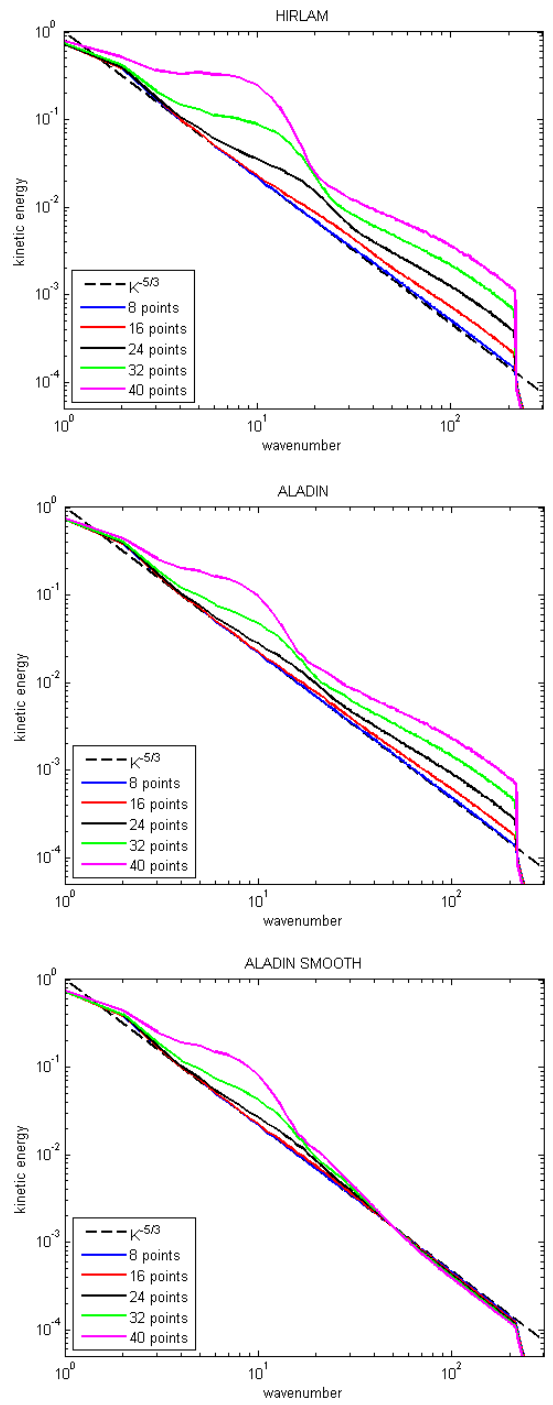
Figure 8. Kinetic energy spectra for HIRLAM (top), ALADIN (middle) and ALADIN SMOOTH (bottom) methods for several widths of the extension